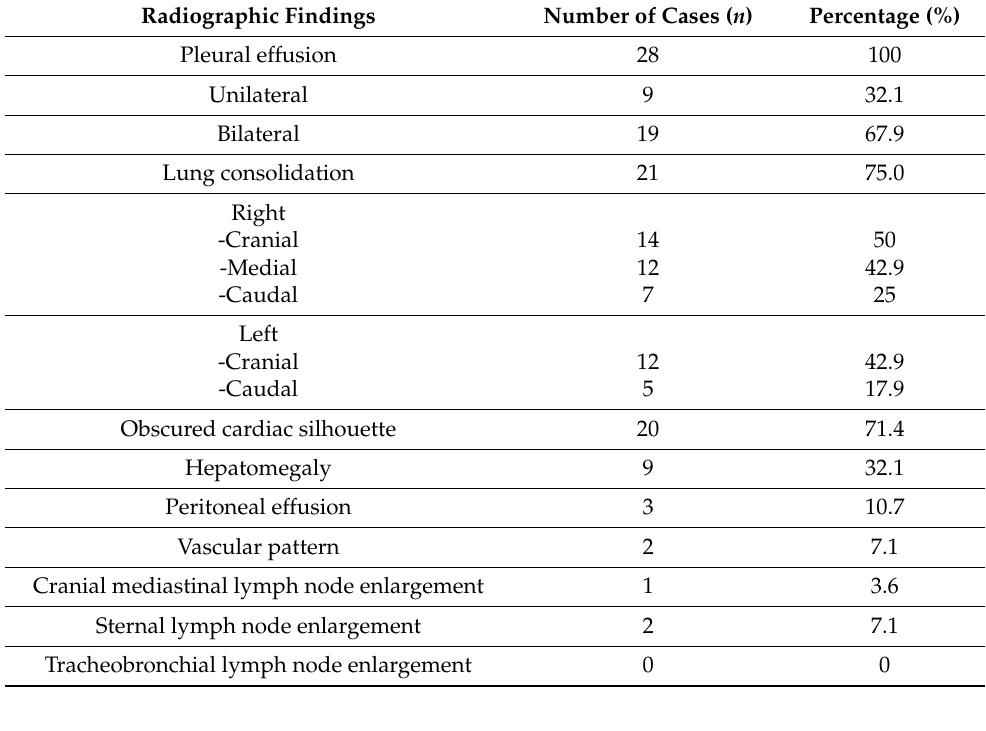
Table 6. Summary of radiographic findings of 28 cats with pyothorax.